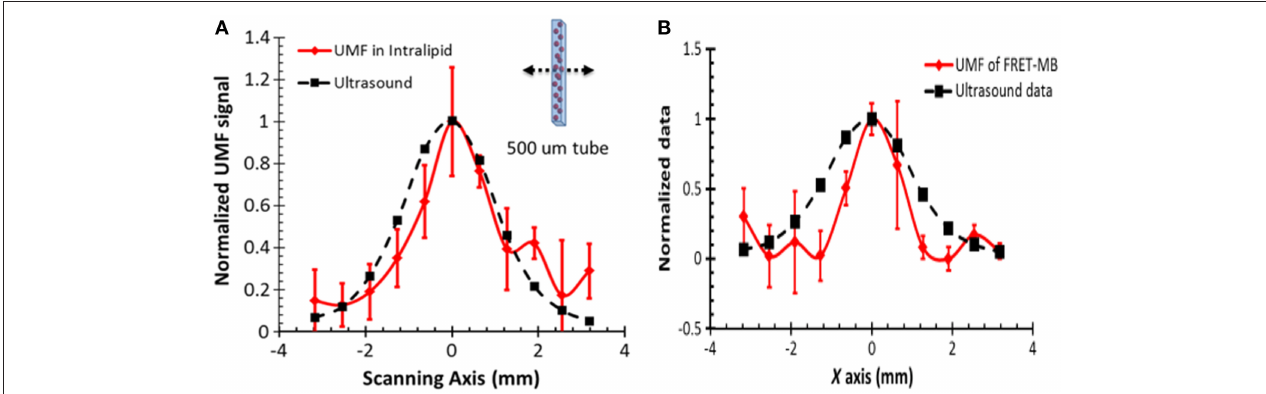
FIGURE 3 | Normalized UFM signal from fluorescent microbubbles filled in a microtube through a 2-mm-thick intralipid slab phantom as a function of the lateral location of the 1-MHz ultrasound transducer. The dotted square line shows ultrasonic echo data that were recorded based on the conventional pulse-echo method. The solid diamond line shows the UMF signal. The arrow in the inset indicates that the transducer was scanned across the tube repeatedly for three times. (A) A single type of dye was attached to the surface of the microbubble and a significant self-quenching effect occurred when no ultrasound was applied (Liu et al., 2014) (B) Microbubbles were simultaneously labeled with donor and acceptor fluorophores on the surface to minimize self-quenching and maximize FRET (Liu et al., 2015). Reproduced with permission. Copyright 2014 & 2015 © SPIE.